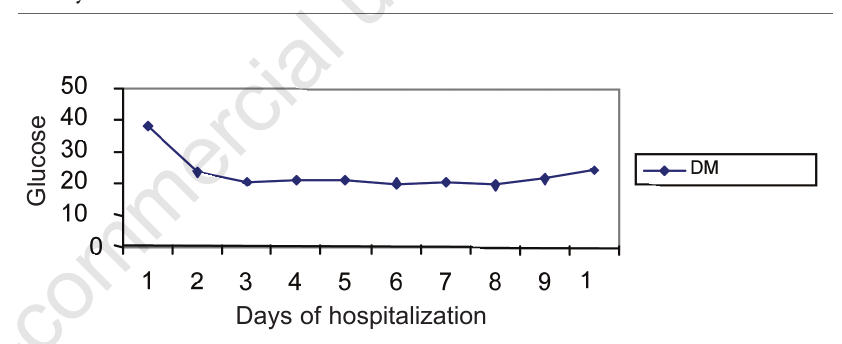
Figure 2. Average blood glucose levels (mg/dL) in diabetics with urinary tract